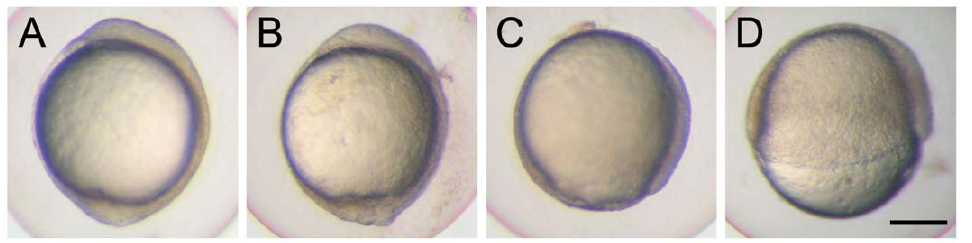
Figure 2. Knockdown of cfl1 causes epiboly defects. Embryos were injected with or without cfl1 MO and photographed at 10 h post- fertilization (hpf). The cfl1 MO caused epiboly defects of different severities. (A) A sham-injected embryo reached 100% epiboly. (B) A cfl1 morphant with a malformed tail bud. (C) A cfl1 morphant that reached 90% epiboly. (D) A cfl1 morphant that reached 50% epiboly. Scale bar, 200 m m.